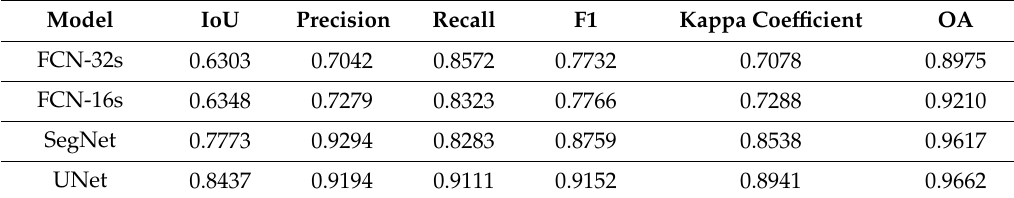
Table 6. Evaluation metrics over the validation set per model.